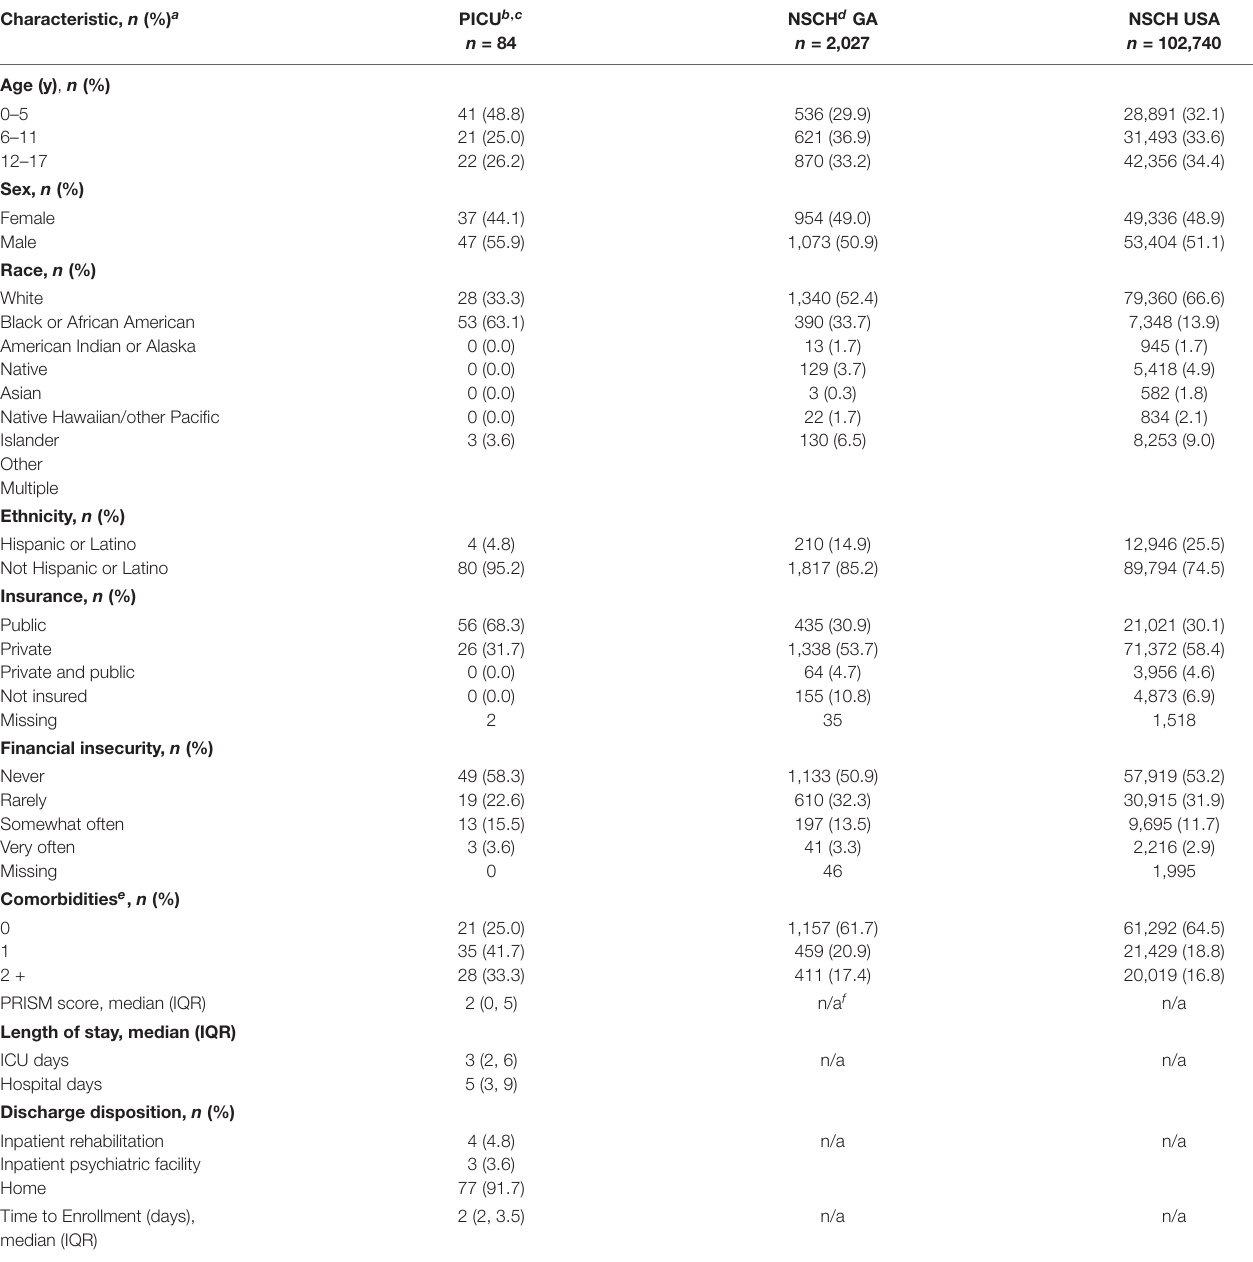
TABLE 1 | Patient demographics and clinical